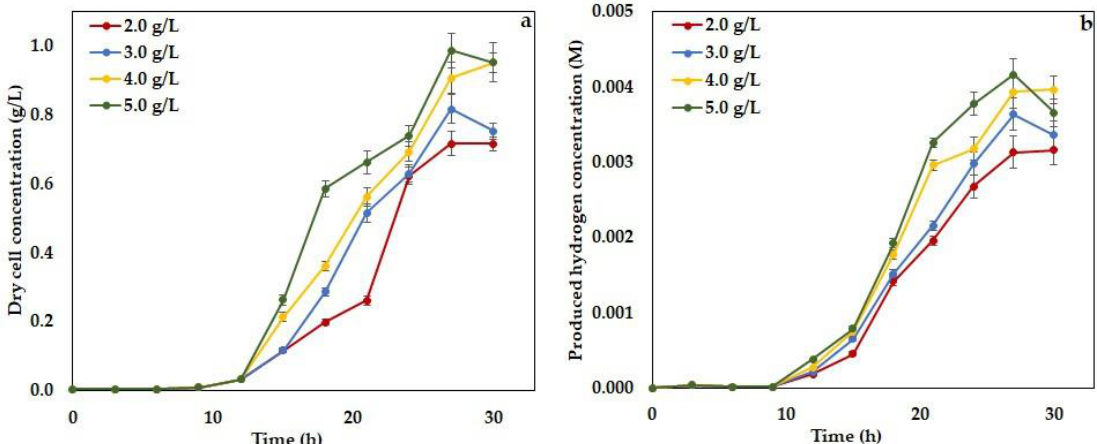
Figure 9. Experimental time histories of dry cell concentration ( a ) and hydrogen concentration ( b ) with initial 40% H 2 in reactor headspace at different substrate concentration.